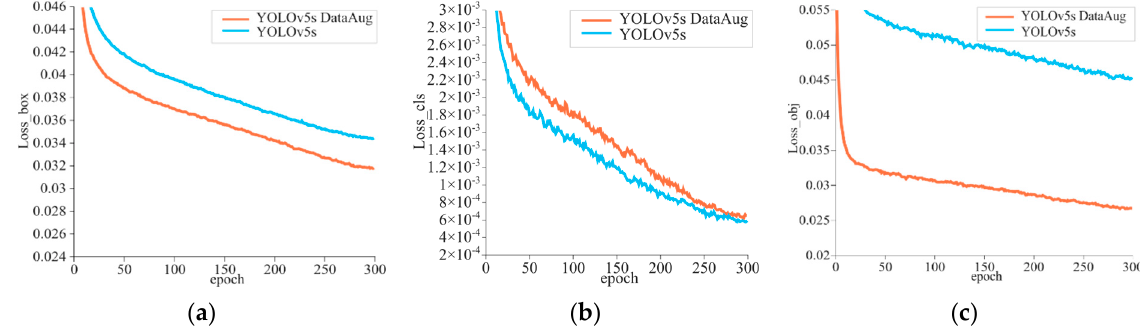
Figure 4. Loss curve of the training process. ( a ) Loss_box, ( b ) Loss_cls, ( c ) Loss_obj.